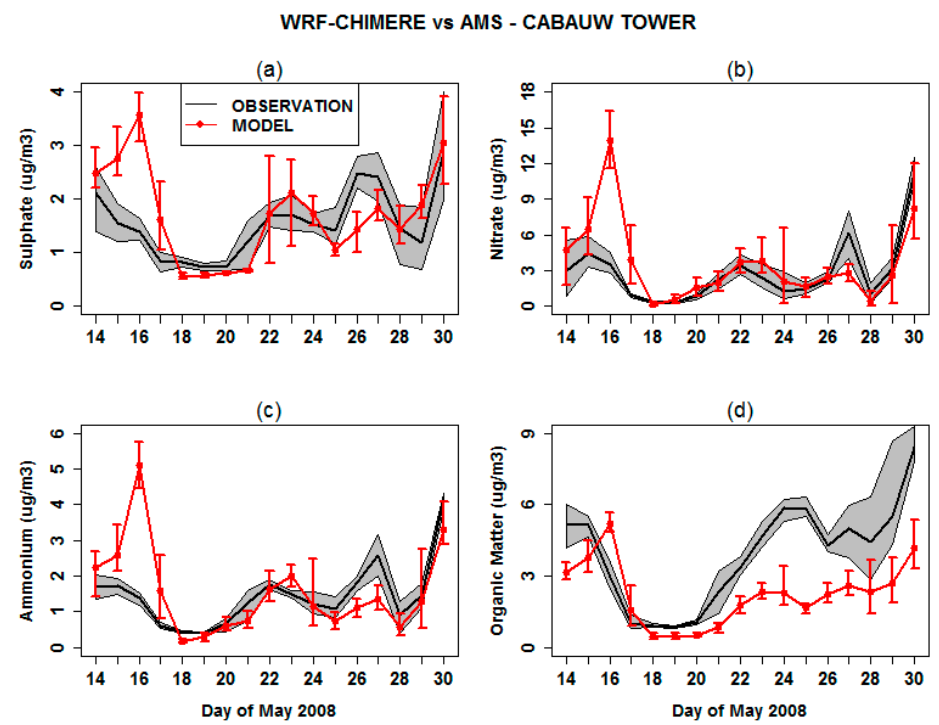
with shaded area and red bar denoting the 25th and 75th percentiles. Daily TMs and interquartile ranges are calculated starting from hourly modelled and observed and modelled values. Statistical indices obtained from the comparison are listed in Table 3.